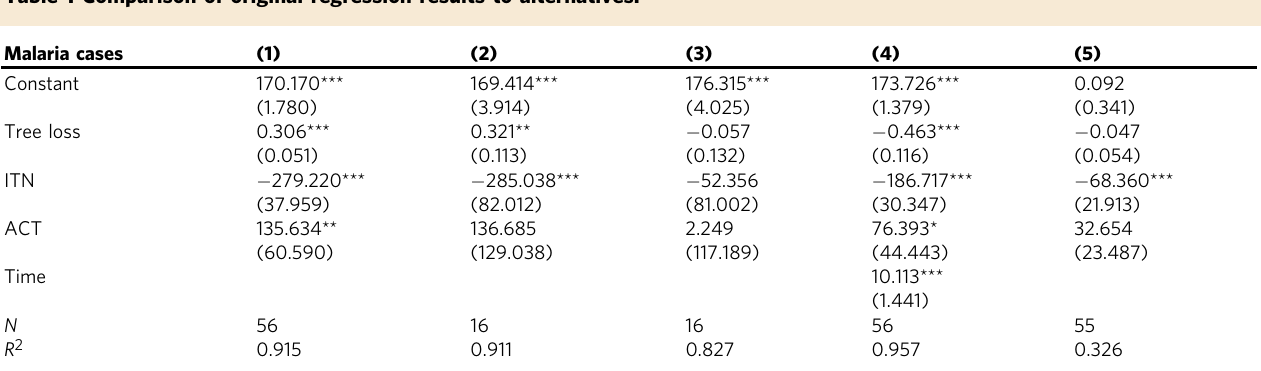
Fig. 1 Time series under consideration. Variables are malaria cases (in million), cumulative tree cover loss (in million hectare), percent sleeping under insecticide-treated nets (ITN) and percent of under-5 fevers receiving artemisinin-based combination therapies (ACT). Table 1 Comparison of original regression results to